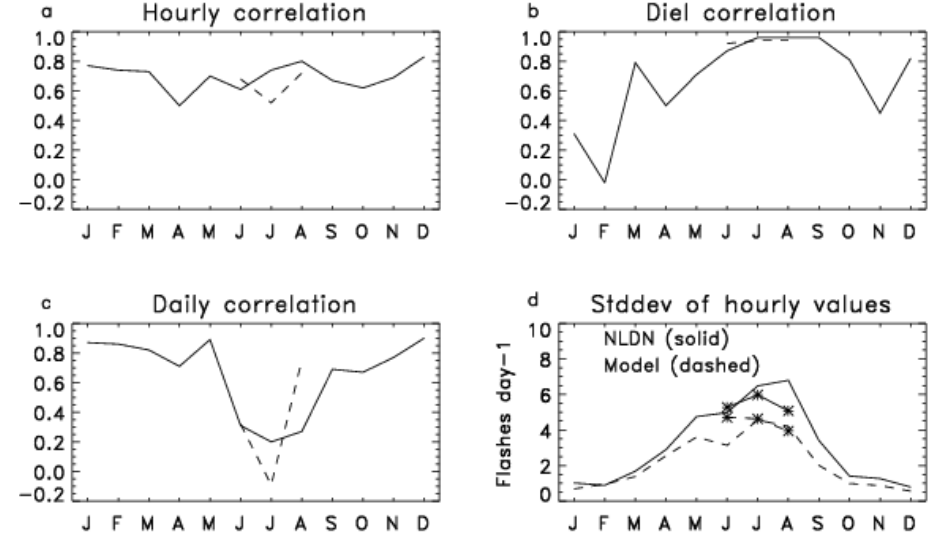
Fig. 3. Time series summarizing the agreement between model and NLDN-based total flash rates for January–December 2006 and June Figure 3. Time series summarizing the agreement between model and NLDN-based total through August 2004. (a) Correlation between flash rates for individual hours within each month, (b) correlation between hourly flash rates after averaging out daily variations, (c) correlation between daily-total flash rates, and (d) standard deviation of model and measured hourly flash rates. For (a – c) , the solid lines show 2006 and the dashed lines show 2004. For (d) , the solid line shows the standard deviation of the data and the dashed line shows the standard deviation of the model; results for 2004 are identified by